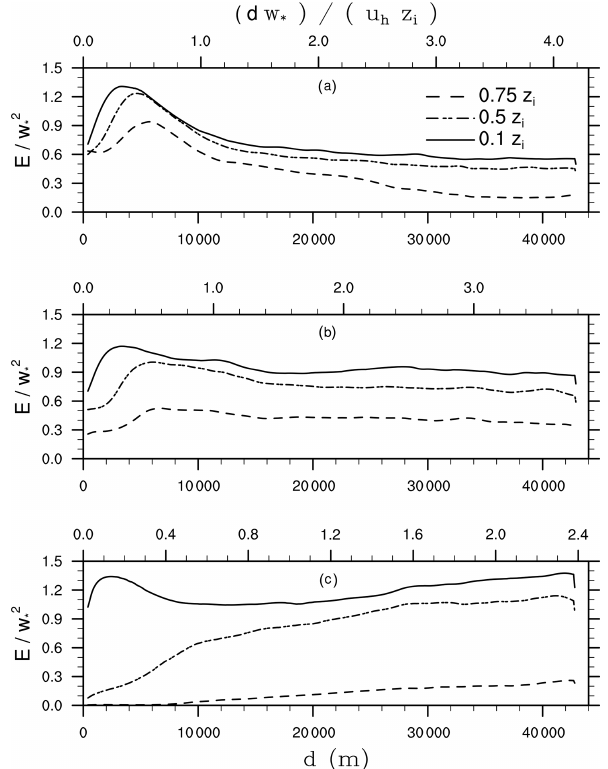
Figure 14. Horizontal profiles of 30min time-averaged resolved- scale TKE depending on the distance to the inflow boundary. The TKE is shown for the lower, middle, and upper parts of the bound- ary layer at (a) 10:00UTC, (b) 13:00UTC, and (c) 16:00UTC. The lower abscissa indicates the absolute distance to the inflow bound- ary, while the upper abscissa indicates the travel time of an imposed signal normalized with the eddy-turnover time. The TKE is aver- aged over similar distances to the inflow